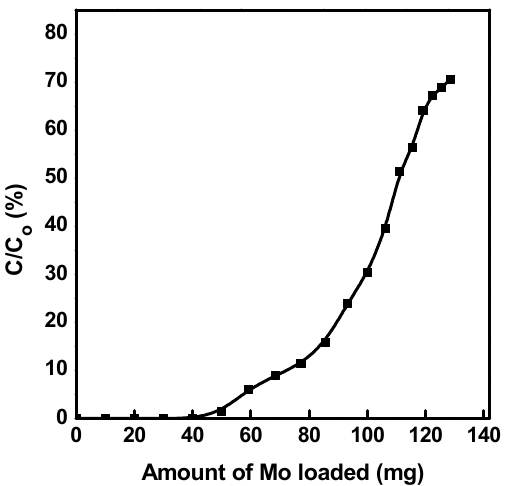
Figure 5. Breakthrough profile of CA- 99 Mo on mesoporous alumina (SA-517747). The data obtained from the distribution ratio (K d ) and the dynamic sorption profile of CA- 99 Mo are promising for developing a 99 Mo/ 99m Tc generator based on mesoporous alumina using a higher amount of activity, about 500 MBq (13.5 mCi). Then, the column was washed and conditioned for the elution of the generated 99m Tc by passing two con- secutive solutions, namely acetate buffer solution and 0.9% saline solution, through the column. Eventually, the 99m Tc elution profile was further studied.